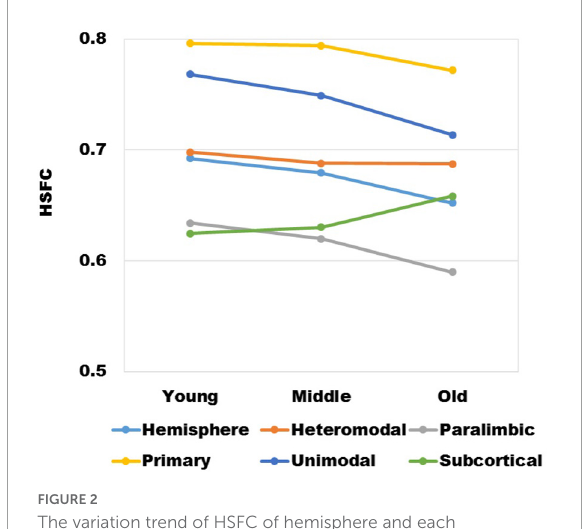
FIGURE2 The variation trend of HSFC of hemisphere and each sub-module (heteromodal, parallel, primary, unimodal, subcortical) in the process of